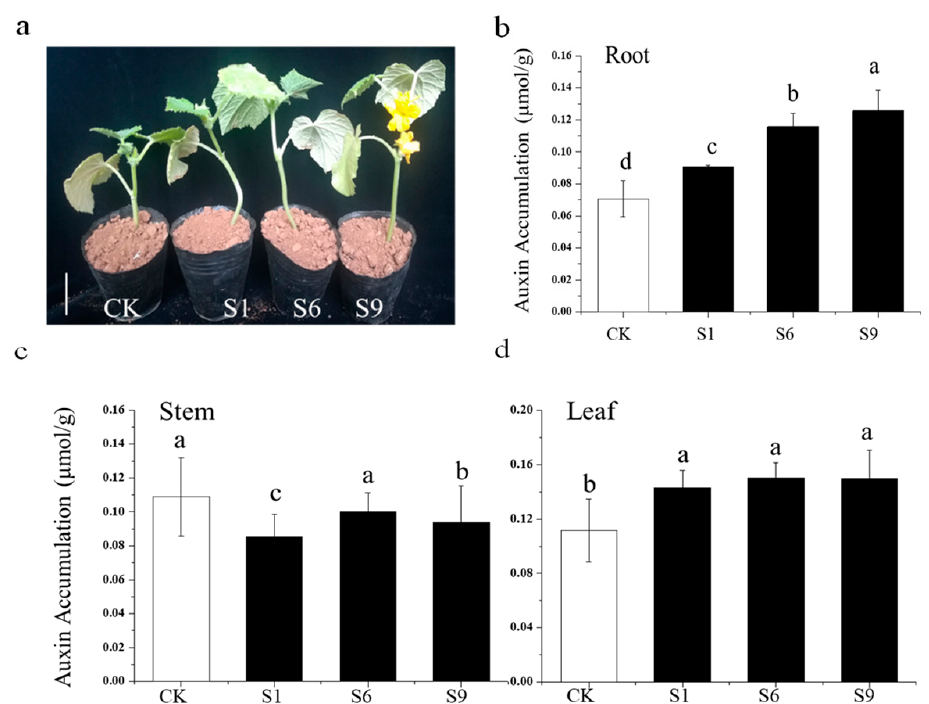
Figure 8. ( a ) Cucumber plant development of the control check (CK) and CsSAUR31 overexpression (S). ( b − d ) Auxin levels in the roots ( b ), stems ( c ), and leaves ( d ) of the control check (CK) and CsSAUR31 -overexpressing plants. The data are the means of three replicates with SEs, and different letters indicate a significant difference ( p < 0.05 by Tukey’s test).